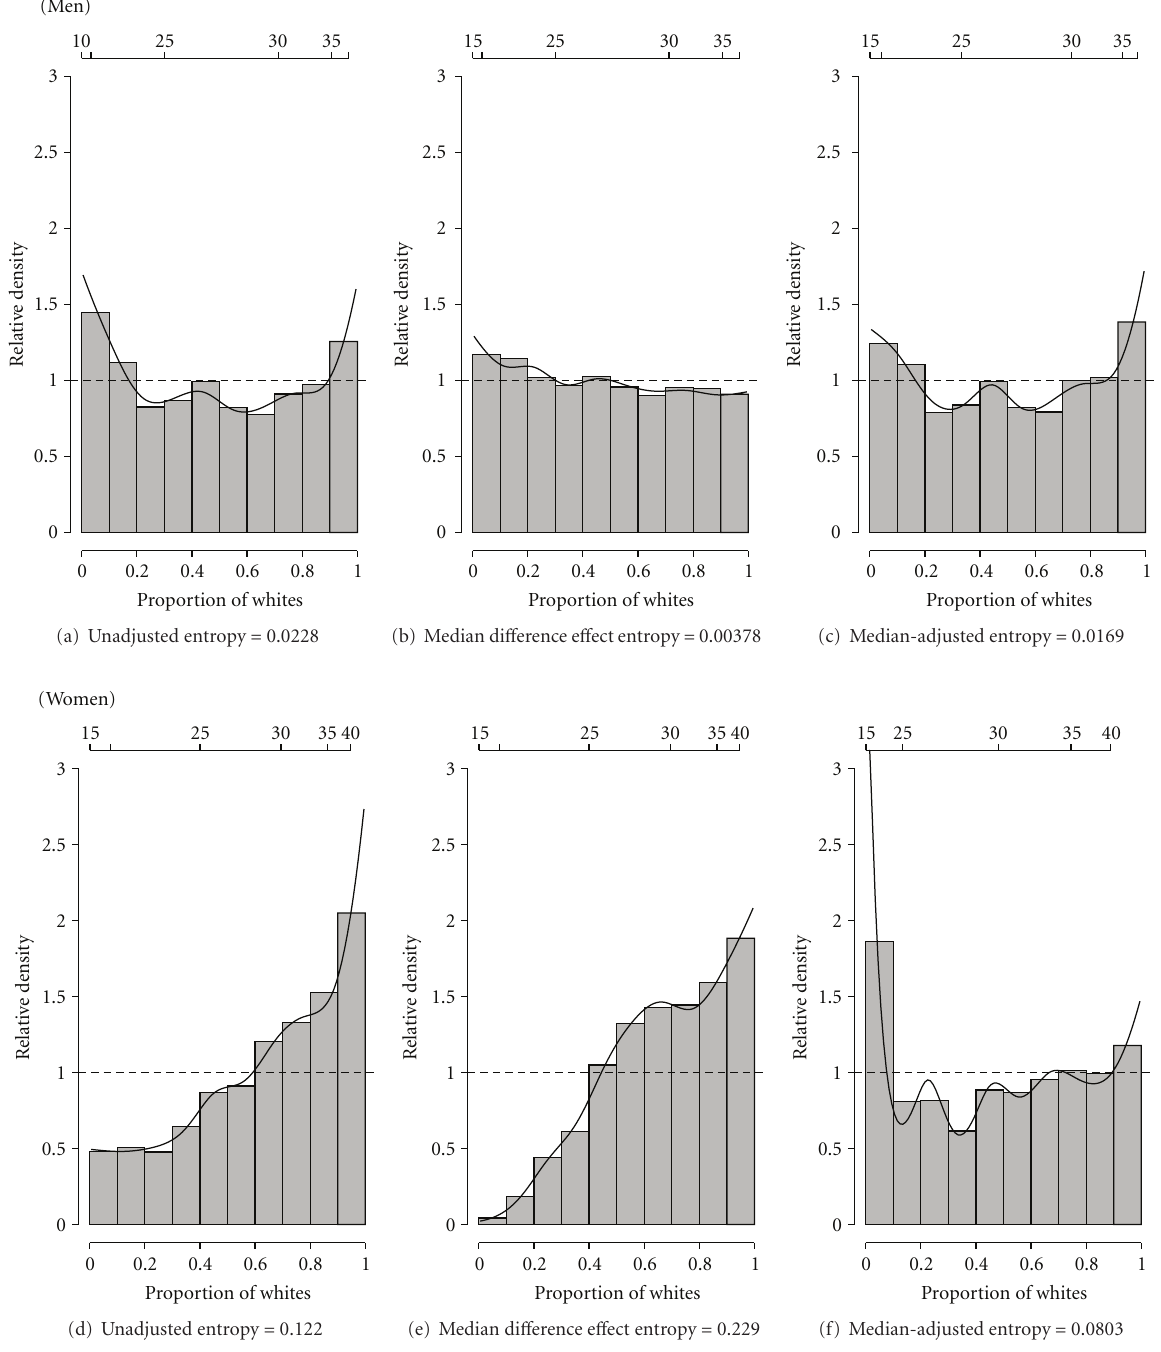
Figure 2: Decomposing relative body mass index distributions (1999–2006) between non-Hispanic Black and White men (top) and women (bottom) into impact of changes in medians and changes in shape. (a,d) Unadjusted relative body mass index density; (b,e) e ff ect of median di ff erence in body mass index between race/ethnic subgroup; (c,f) median-adjusted relative body mass index density. Deciles chart superimposed on relative densities. Data from the National Health and Nutrition Examination